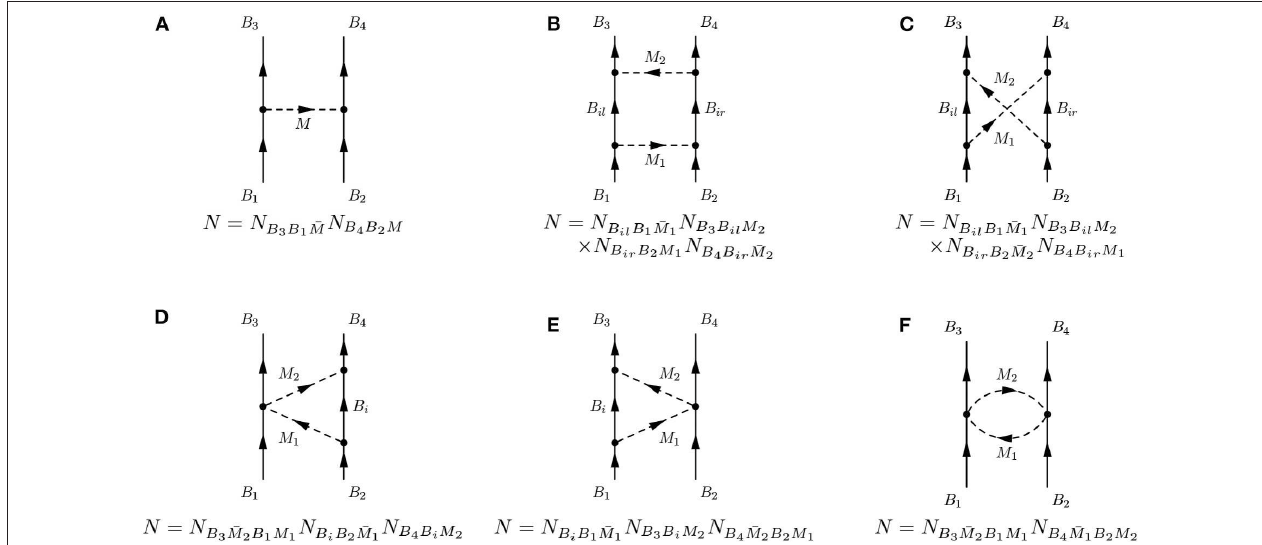
FIGURE 7 | One- and two-meson-exchange contributions and corresponding SU(3) factors. (A) One-meson exchange, (B) planar box, (C) crossed box, (D) left triangle, (E) right triangle, and (F) football diagram.